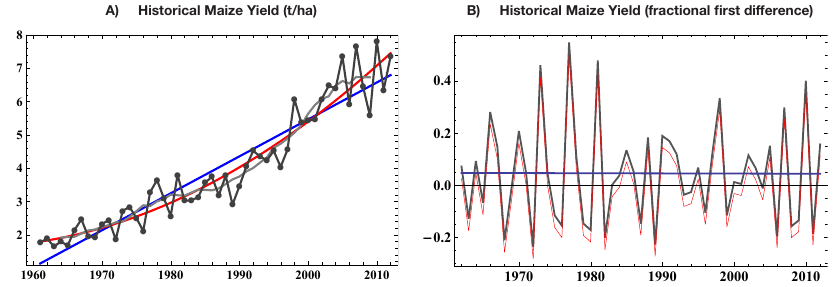
Figure 6. (a) FAOSTAT yield for maize in Argentina (solid line and points) with the linear (blue) and quadratic (red) best-fits and 7-year moving average (gray). (b) Fractional first difference of maize yields in Argentina (gray), the linear trend (blue line) and the fractional first difference with the trend removed (red).